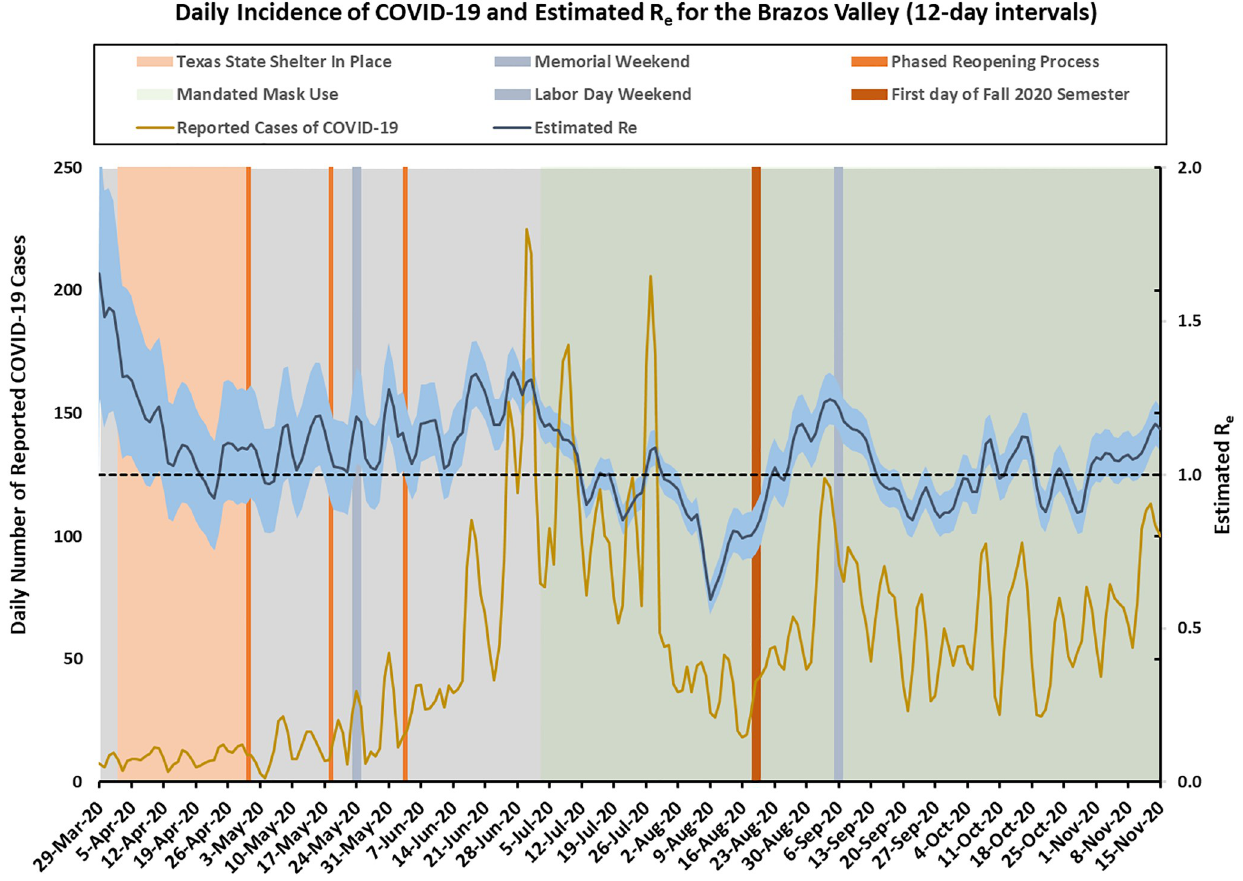
Fig 4. Brazos Valley incidence cases over time (smoothed) and the estimated effective reproduction number R e ( t ) (95% CI in shaded area) using 12-day